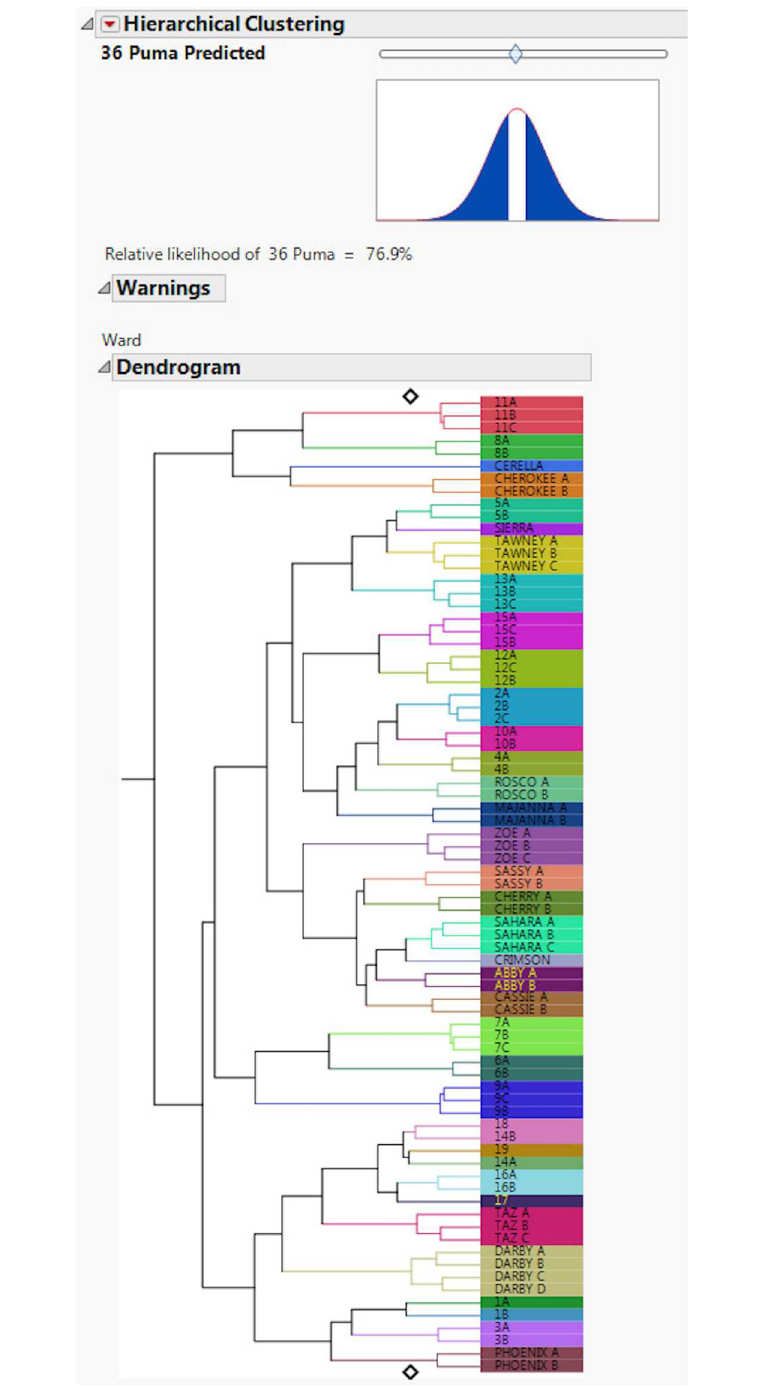
Fig 8. This figure demonstrates that when the slider is moved to the right the likelihood of 36 cougars is